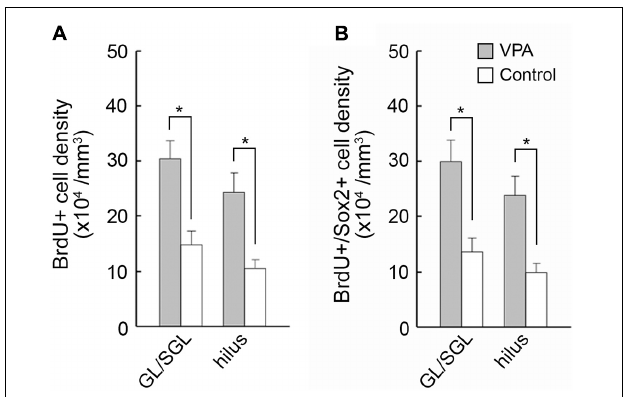
FIGURE 5 | The 5-bromo-2-deoxyuridine (BrdU)-labeled cell density and BrdU-labeled Sox2-immunopositive progenitor density in the dentate gyrus of premature hippocampi in postnatal day (PD) ferrets. (A) BrdU-labeled cell density. (B) BrdU-labeled Sox2-immunopositive progenitor density. Data are shown as mean ± SEM. Significance is indicated using Scheffe’s test at * P < 0.001; number of hippocampi = 8; GL, granular layer; SGL, subgranular layer.